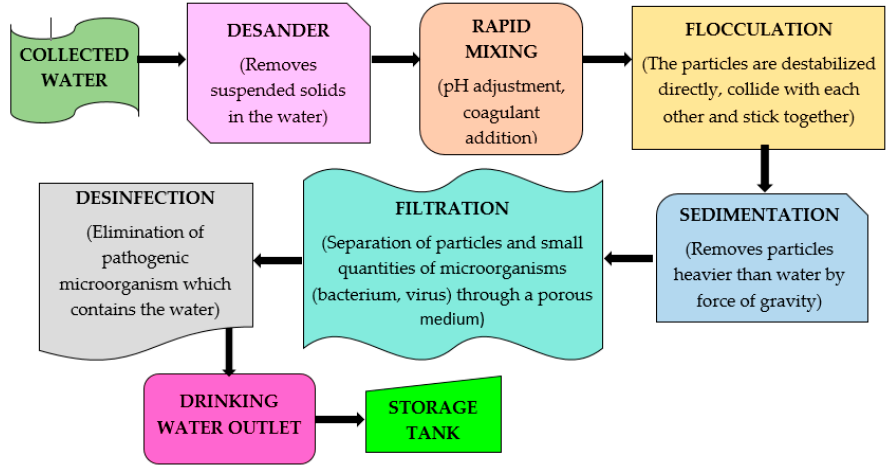
Figure 3. Diagram of the unit operations that makes up the drinking-water treatment plant.